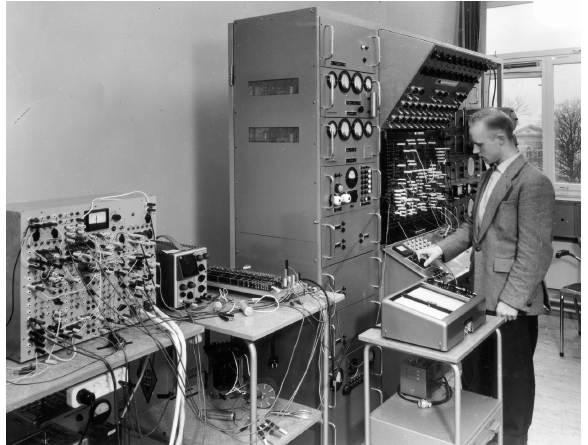
Figure 6: The analog computer DIANA is built as a tool to solve differential equations for control